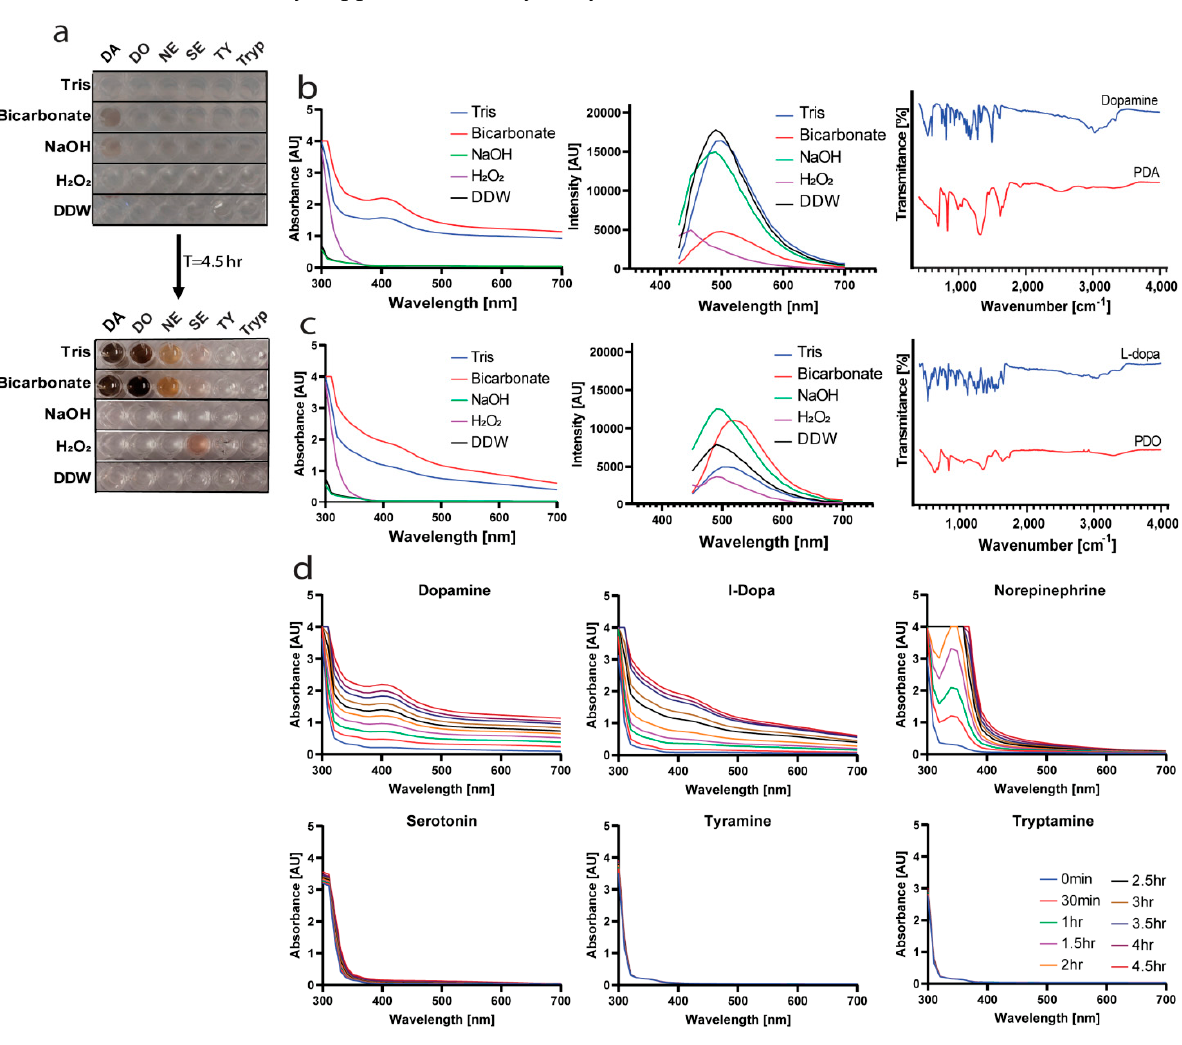
Figure 1. Polymerization process. ( a ) Different polymerization conditions and their impact on the polymerization of catecholamines after 4.5 h. Abbreviations: DA = dopamine, DO = L-dopa, NE = norepinephrine, SE = serotonin, TY = tyramine, Tryp = tryptamine. ( b , c ) Absorbance, emission, and ATR spectra of dopamine/PDA ( b ) and L-dopa/PDO ( c ). ( d ) Absorbance spectra of the reactions over time in bicarbonate buffer (0.1 M) and the reactant structures.